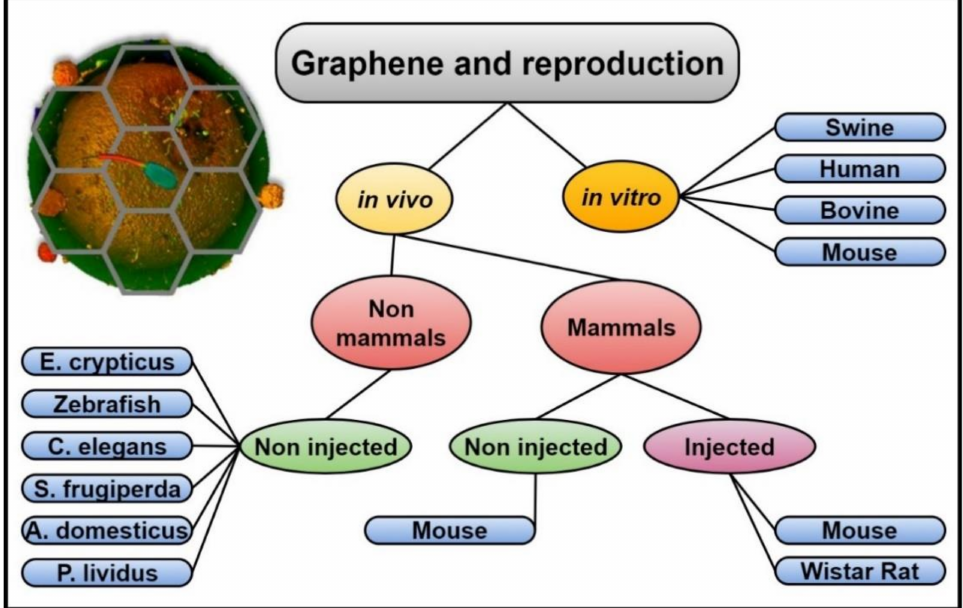
Figure 2. Graphene and reproduction. Graphic outline of the studies involving graphene and reproduction, either in vivo or in vitro, following different protocols and performed in different animal